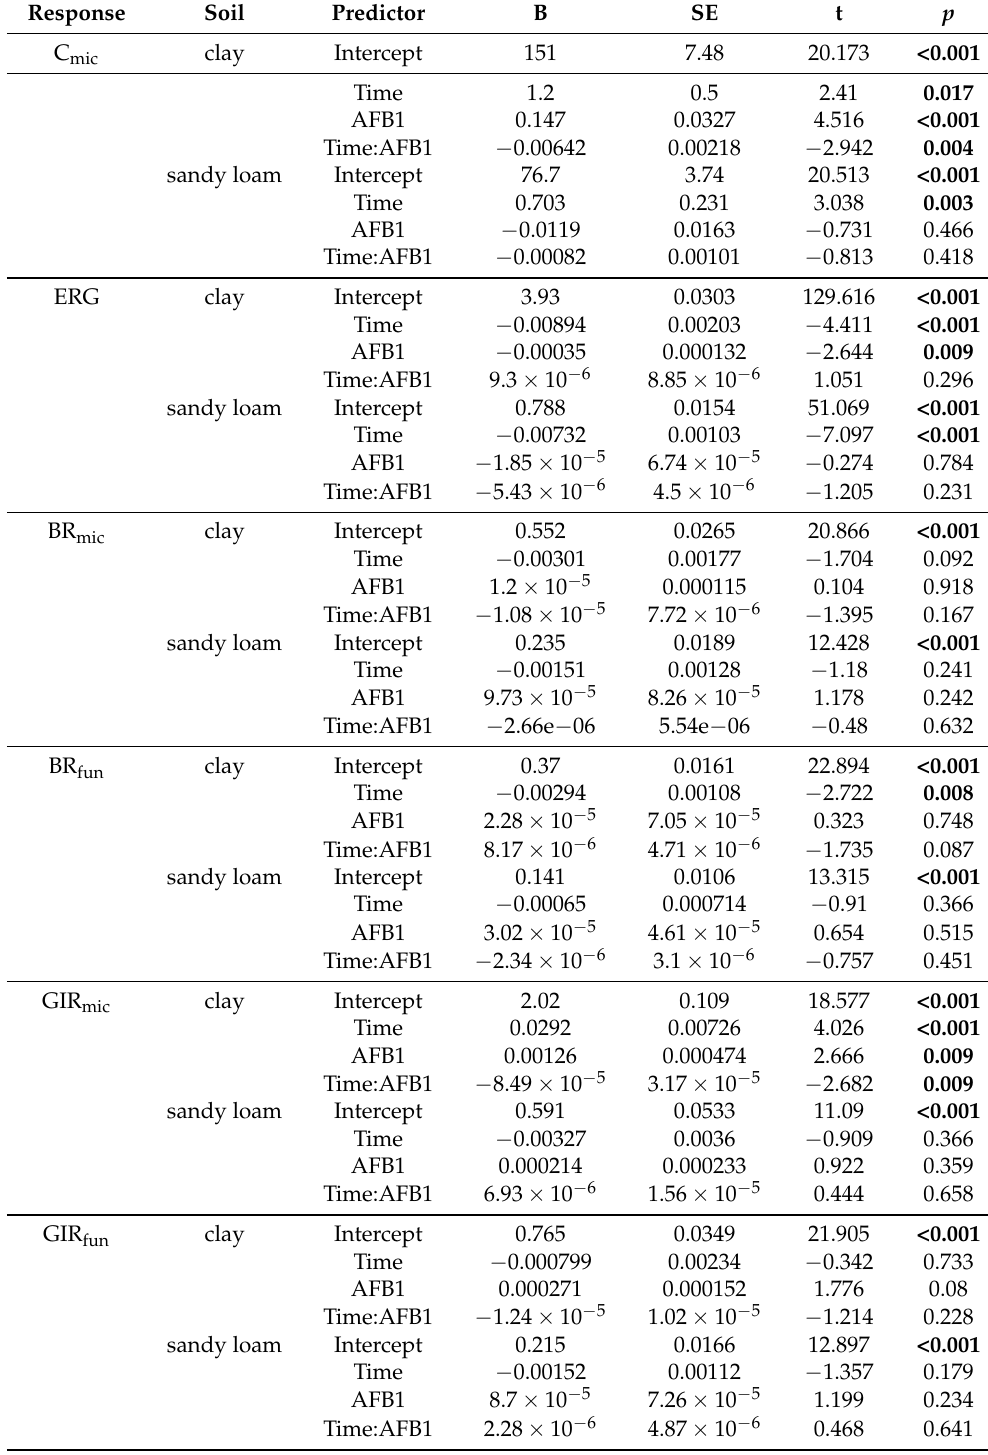
Table A3. Test statistics of the multiple regression models used to evaluate the effect of AFB1 concentration, incubation time and their interaction on soil microbial and ecophysiological parameters. Significant results ( p < 0.05) are shown in